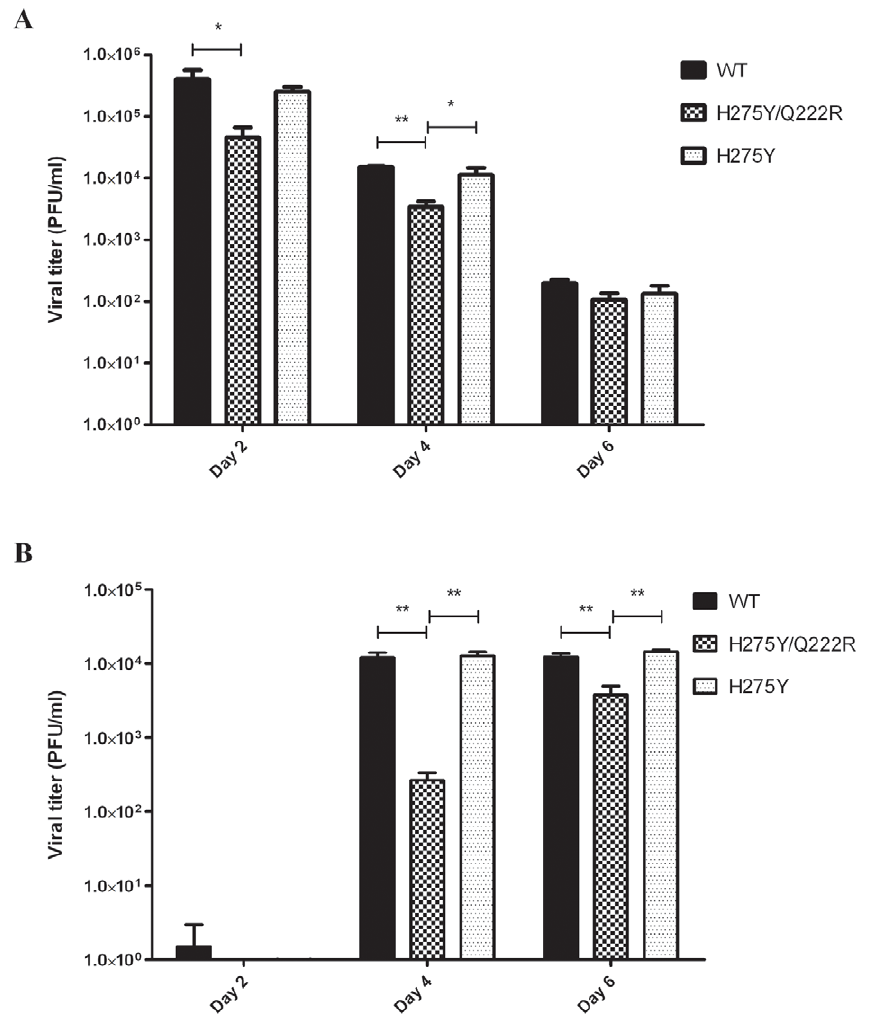
Figure 5. Mean viral titers in nasal wash samples of infected and contact ferrets. Mean viral titers 6 standard deviations were determined in nasal washes by using standard plaque assays in groups of 4 index ferrets infected with 1.25 6 10 5 PFU of recombinant A/Brisbane/59/2007-like wild-type (WT) virus as well as H275Y and H275Y/Q222R mutants (A) and in groups of 4 naı¨ve ferrets that were placed in direct contact with index ferrets 24 h later (B).* P , 0.05 and ** P , 0.01 for differences in viral titers when compared to the recombinant WT